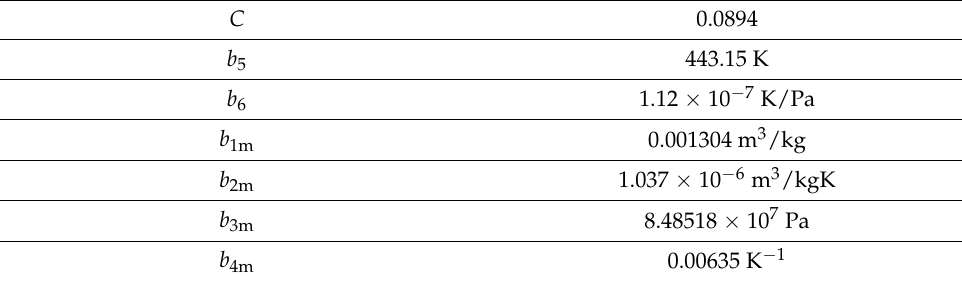
Table 2. Constants of the p - v - T equation for PP